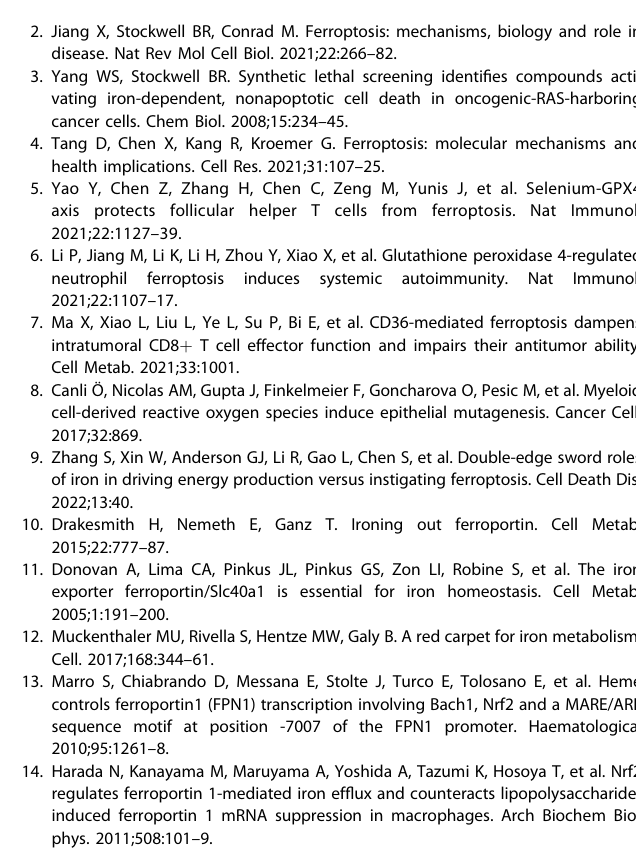
Fig. 4 BACH1 silencing increases ferroportin expression and protects against ferroptosis. A BACH1 protein expression in nuclear extracts of M Φ exposed to 10 µM RSL3 for 6 h. B BACH1 and SLC40A1 mRNA expression in M Φ transfected with control or BACH1 siRNAs for 96 h prior to treatments with 10 µM RSL3 for 24 h. C LIP in M Φ transfected with control or BACH1 siRNAs for 96 h. D , E Lipid ROS ( D ) and viability ( E ) of M Φ transfected with control or BACH1 siRNAs for 96 h prior to treatments with 10 µM RSL3 for 6 ( D ) or 24 h ( E ). Data are presented as means ± SEM ( N ≥